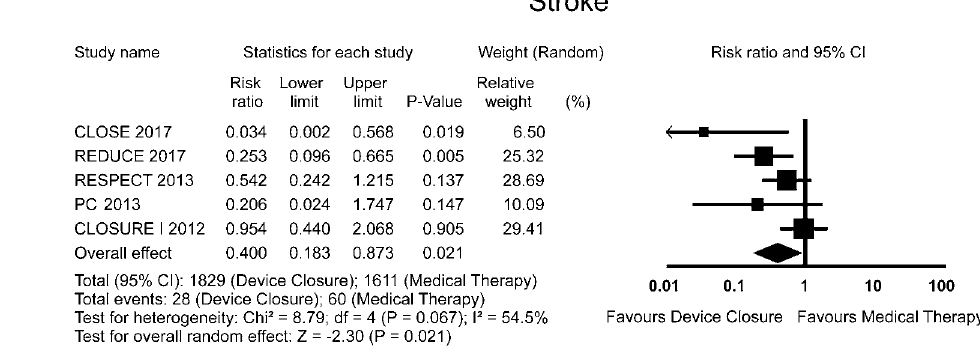
Fig. 2 – Forest plots of efficacy outcomes.